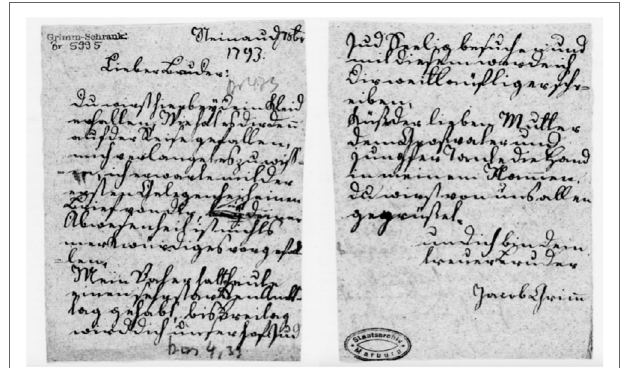
FigUre 1 | Letter written by Jacob Grimm at the age of 8 (Br 5995). A complete transcription of the letter can be read in the Appendix [Image reproduced with permission of the Hessisches Staatsarchiv